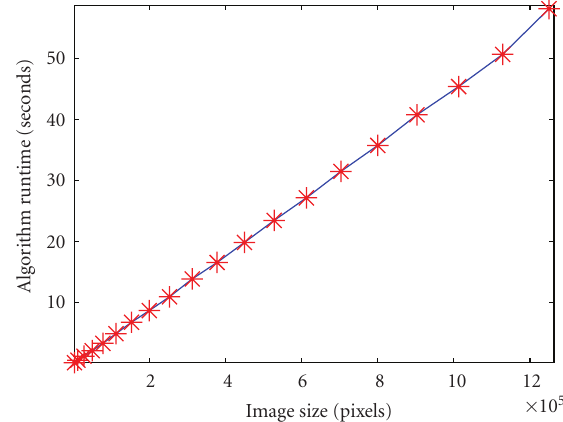
Figure 25: Runtime versus image size. (Space time sequences of